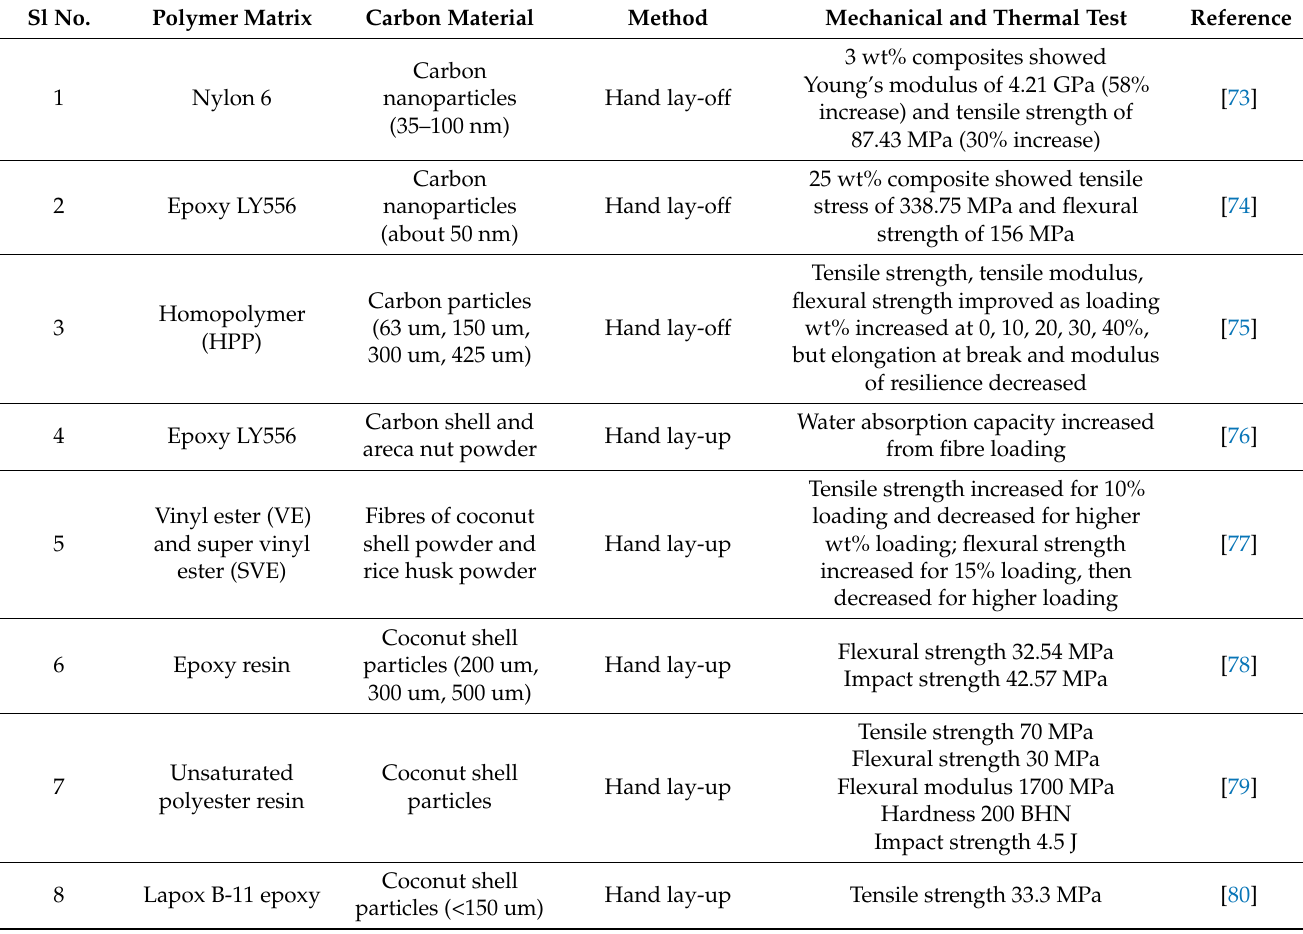
Table 3. Synthesis and characterization of coconut shell